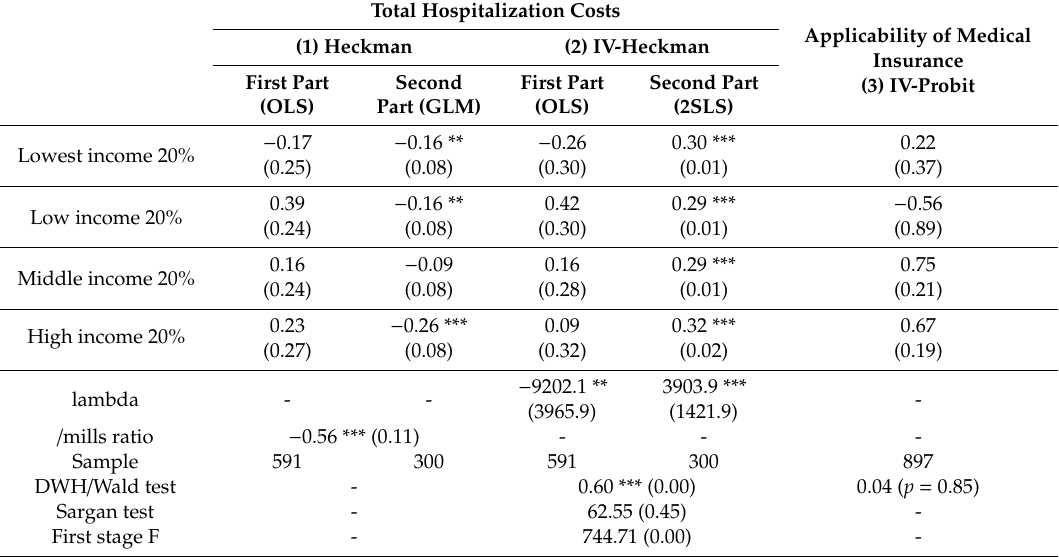
Table 3. Total hospitalization expenses and the applicability of medical